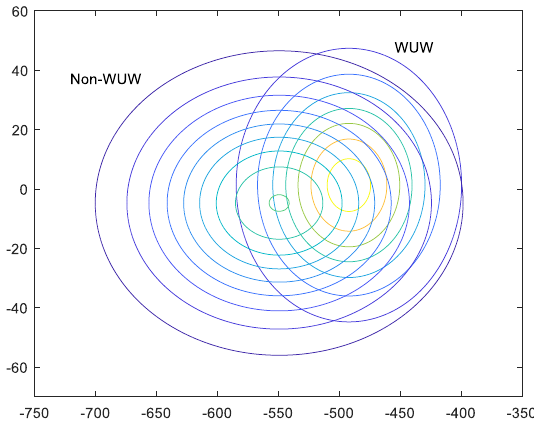
Figure 3. Distribution contour curves of two-dimensional vector obtained through PCA (Principal Component Analysis) transform of the log-spectral features for WUW and non-WUW speech utterances.